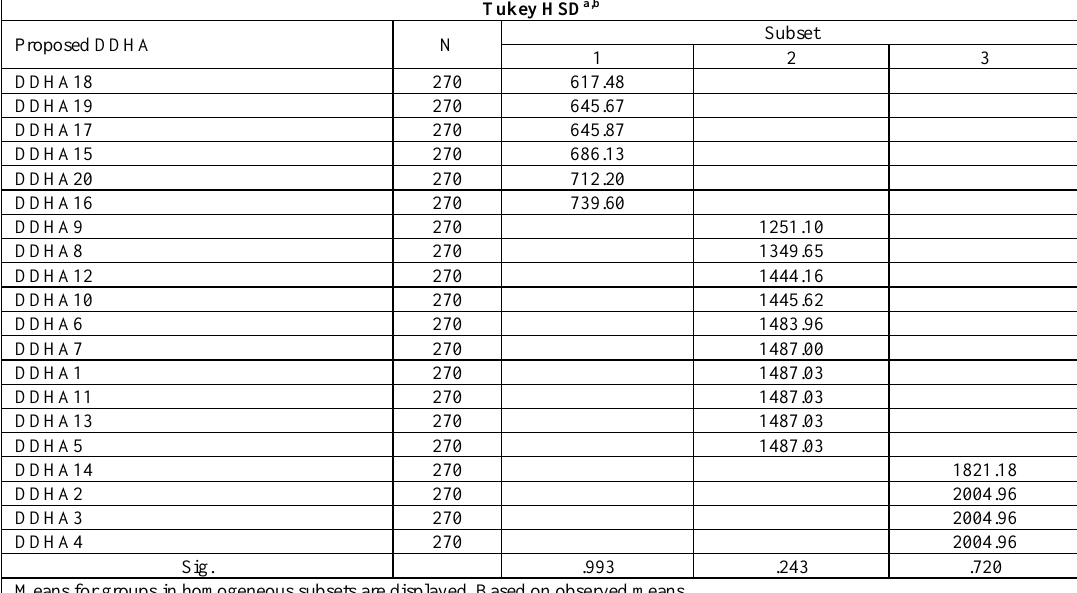
Table 7. Means for groups in homogeneous